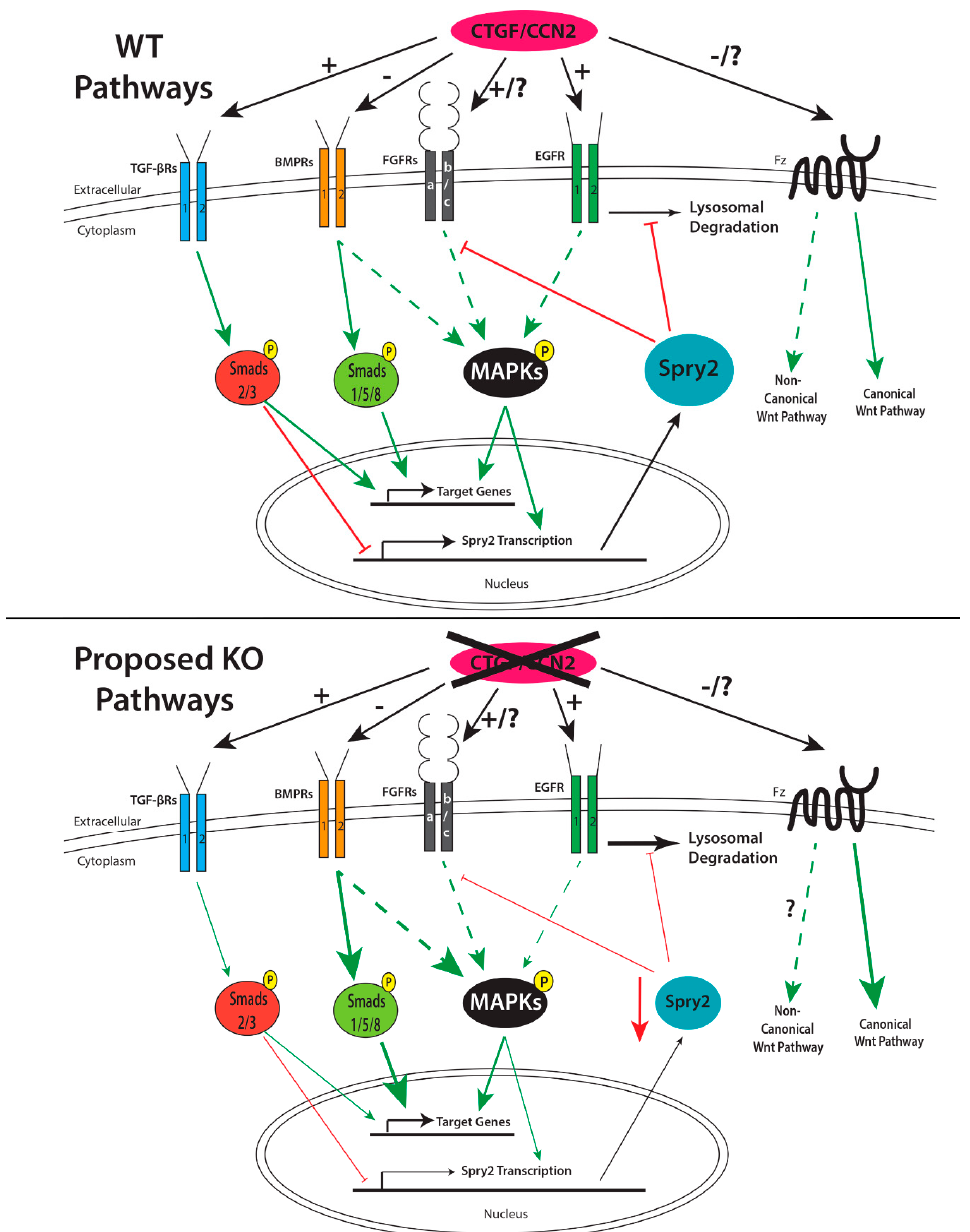
Figure 5. Summary of the role of CCN2 in palate developmental pathways in the WT environment and proposed effects in the CCN2 KO setting. In the absence of CCN2, some signaling pathways (e.g., TGF- β , EGF, and FGF) may be reduced, while other pathways (e.g., BMP and the canonical Wnt pathway) may be augmented. On the other hand, if the FGF pathway inhibitor SPRY2 is decreased, this could result in increased FGFR and EGFR signaling. In the absence of CCN2, the potential for dramatically altered expression of downstream target genes for each of these signaling pathways exists and warrants further exploration in the developing palatal shelves of CCN2 KO